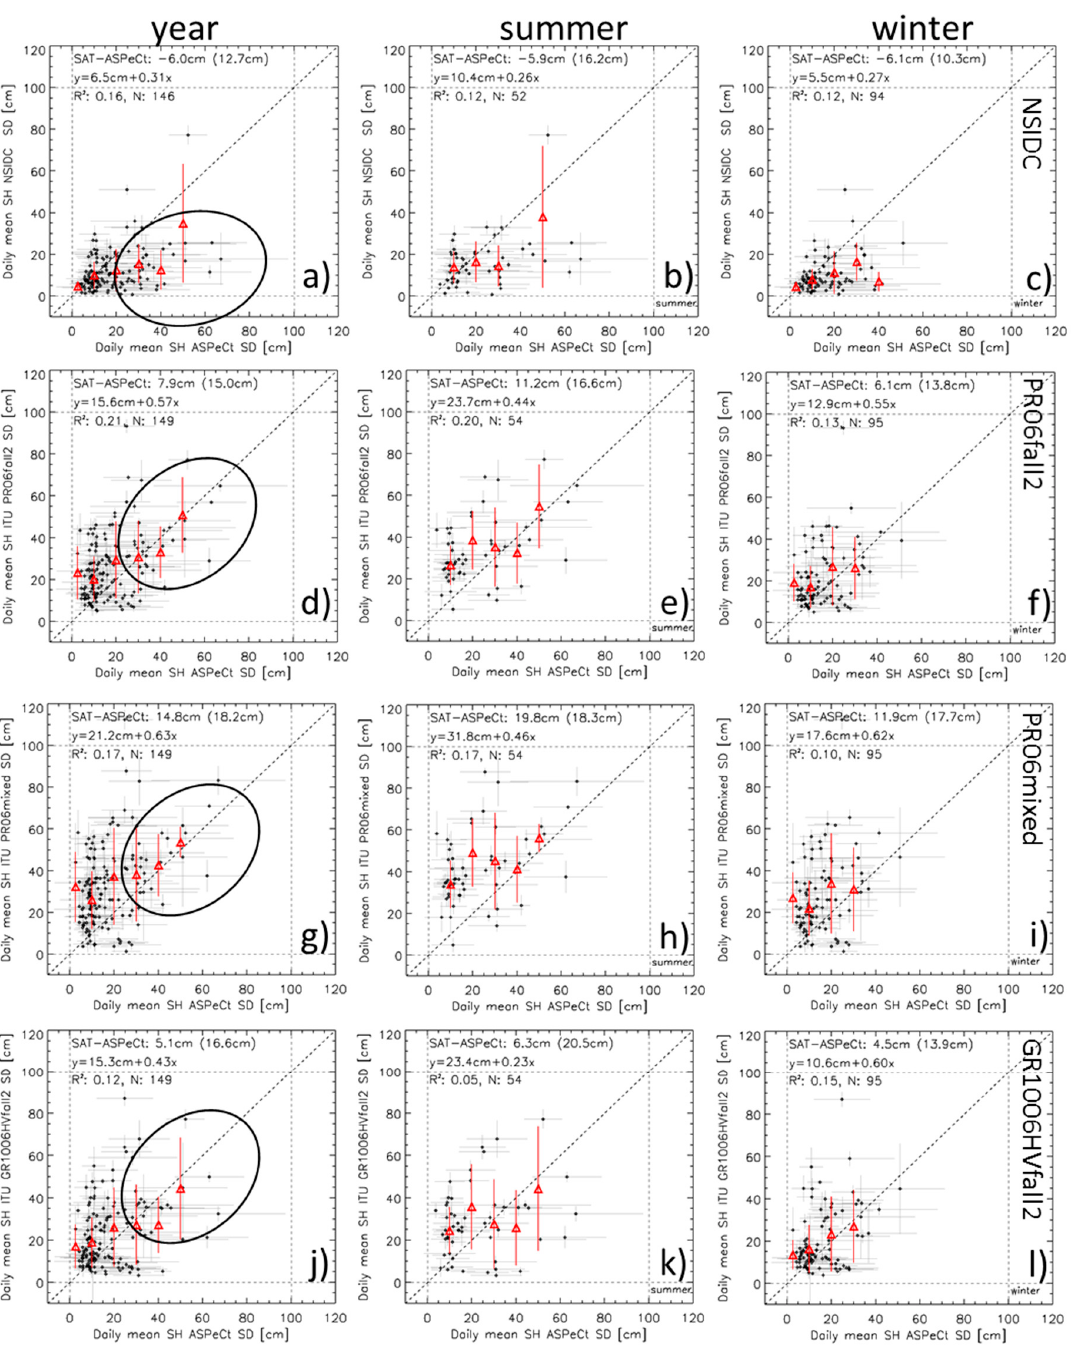
Figure 10. The scatterplots of the daily mean AMSR-E snow depth (y-axis) versus ASPeCt snow depth (x-axis) for the years 2002–2011. The daily mean along-ship track values (black dots), one standard deviation of the mean (grey bars), and an identity line (dashed diagonal) are shown. The mean difference and its standard deviation are given at the top, followed by the linear regression equation, the squared linear correlation coefficient R 2 , and the number of valid data pairs N . Red triangles (error bars) denote the mean (one standard deviation) AMSR-E snow depth for the binned ASPeCt snow depths. See text for black ellipses.